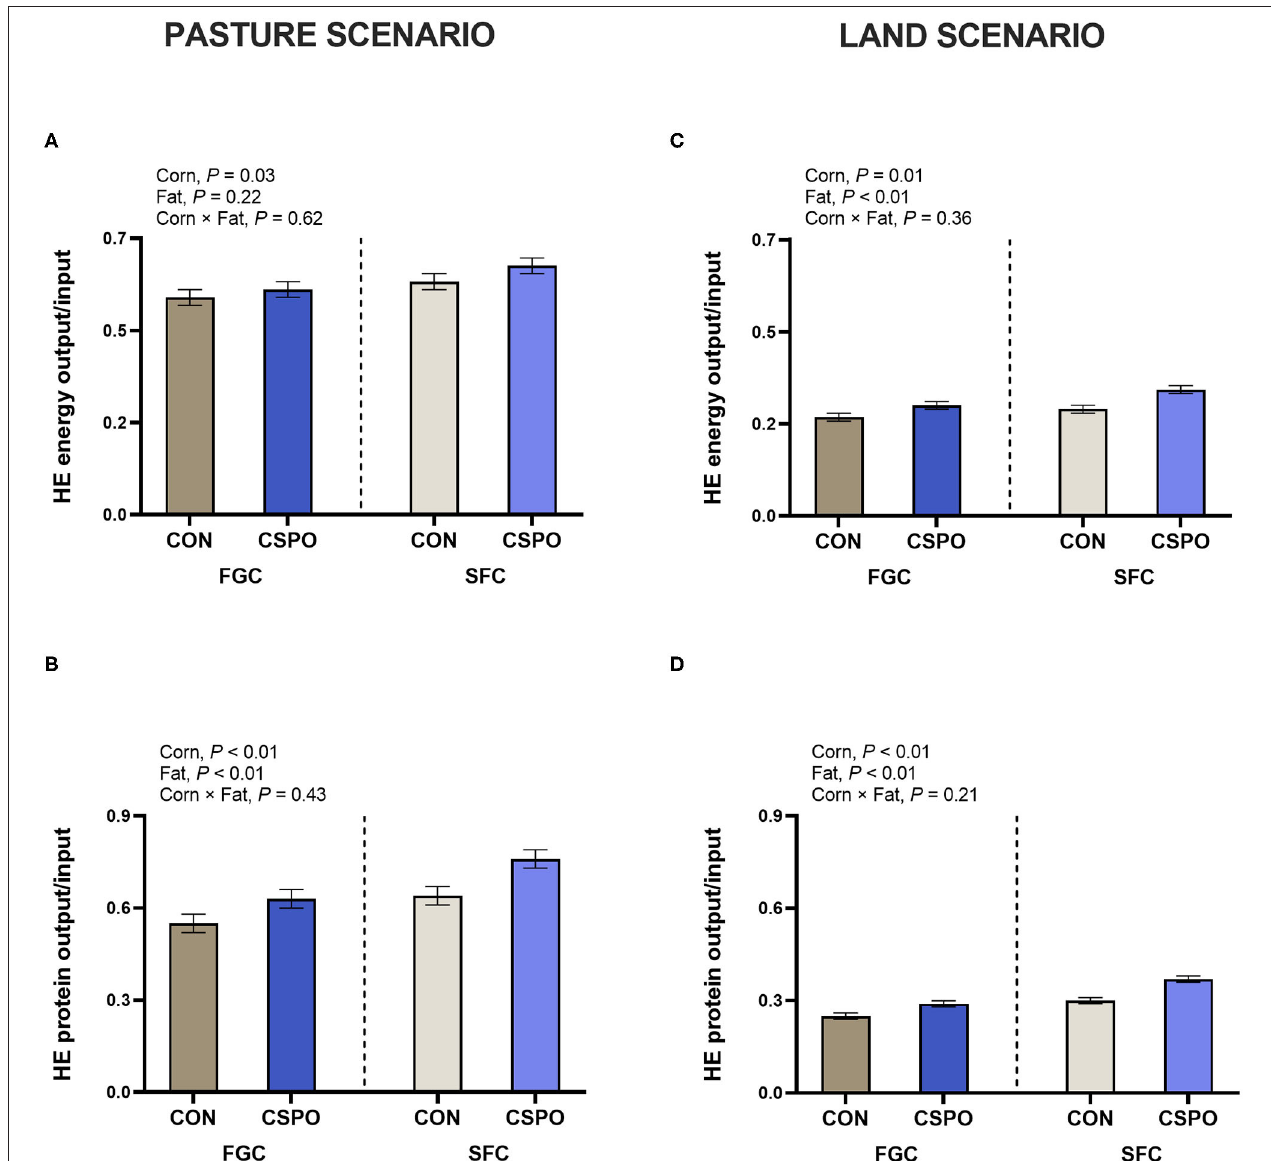
FIGURE 2 | Human-edible (HE) metabolizable protein (bottom) and energy (top) conversion rate in cows that grazed elephant grass and received treatments as a concentrate supplement in a pasture scenario (A,B) or land scenario (C,D) . The concentrate contained either fine ground corn (FGC) or steam-flaked (SFC) corn associated or not with supply of Ca salts of palm fatty acids (not supplemented—CON or